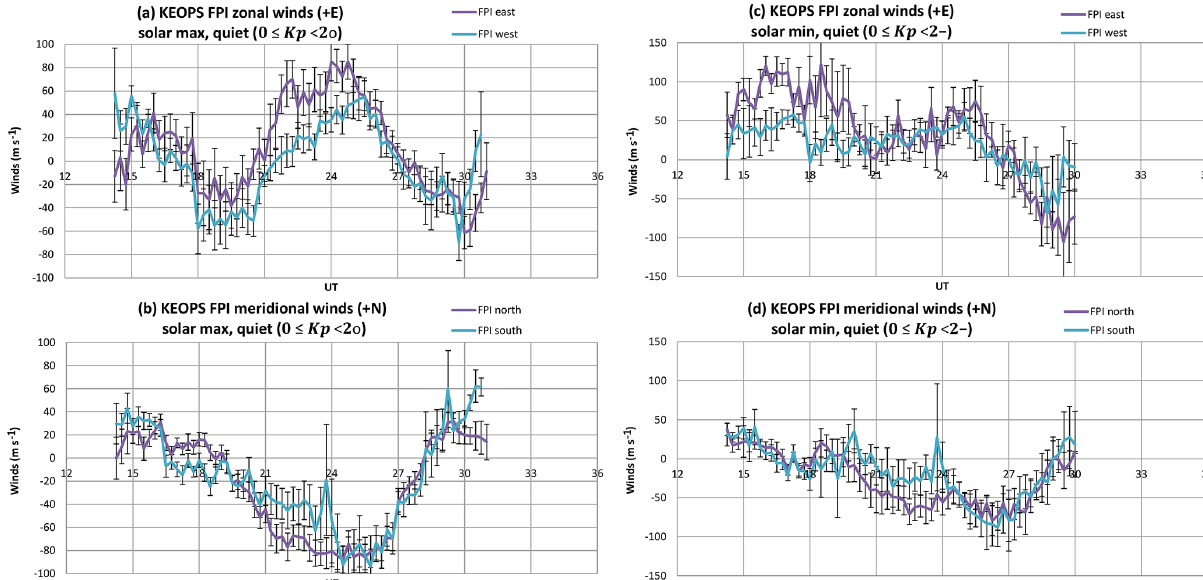
Figure 7. Panels (a) and (b) show the solar maximum (2001–2003) FPI winter average wind components at KEOPS for geomagnetically quiet conditions (0 ≤ Kp<2 ◦ ). Zonal (a) and meridional (b) average winds and the standard errors of the mean are plotted. North and east are shown using purple lines in (b) and (a) respectively, whereas south and west are shown using light blue lines in (b) and (a) respectively. Panels (c) and (d) show the solar minimum (2005–2007) FPI winter average wind components at KEOPS for geomagnetically quiet conditions (0 ≤ Kp<2 − ). Zonal (a) and meridional (b) average winds and the standard errors of the mean are plotted. North and east are shown using purple lines in (d) and (b) respectively, whereas south and west are shown using light blue lines (d) and (b)